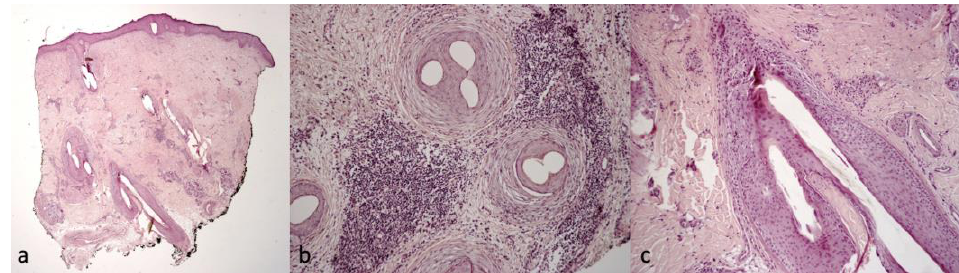
Figure 5. Histological findings of Patients 2 and 3, showing diffuse fibrosis, focal perifollicular suppurative, and mixed infiltrate in the dermis. “Tufted folliculitis” ( a ) 2× magnification, H&E and ( b , c ) 20× magnification, H&E.